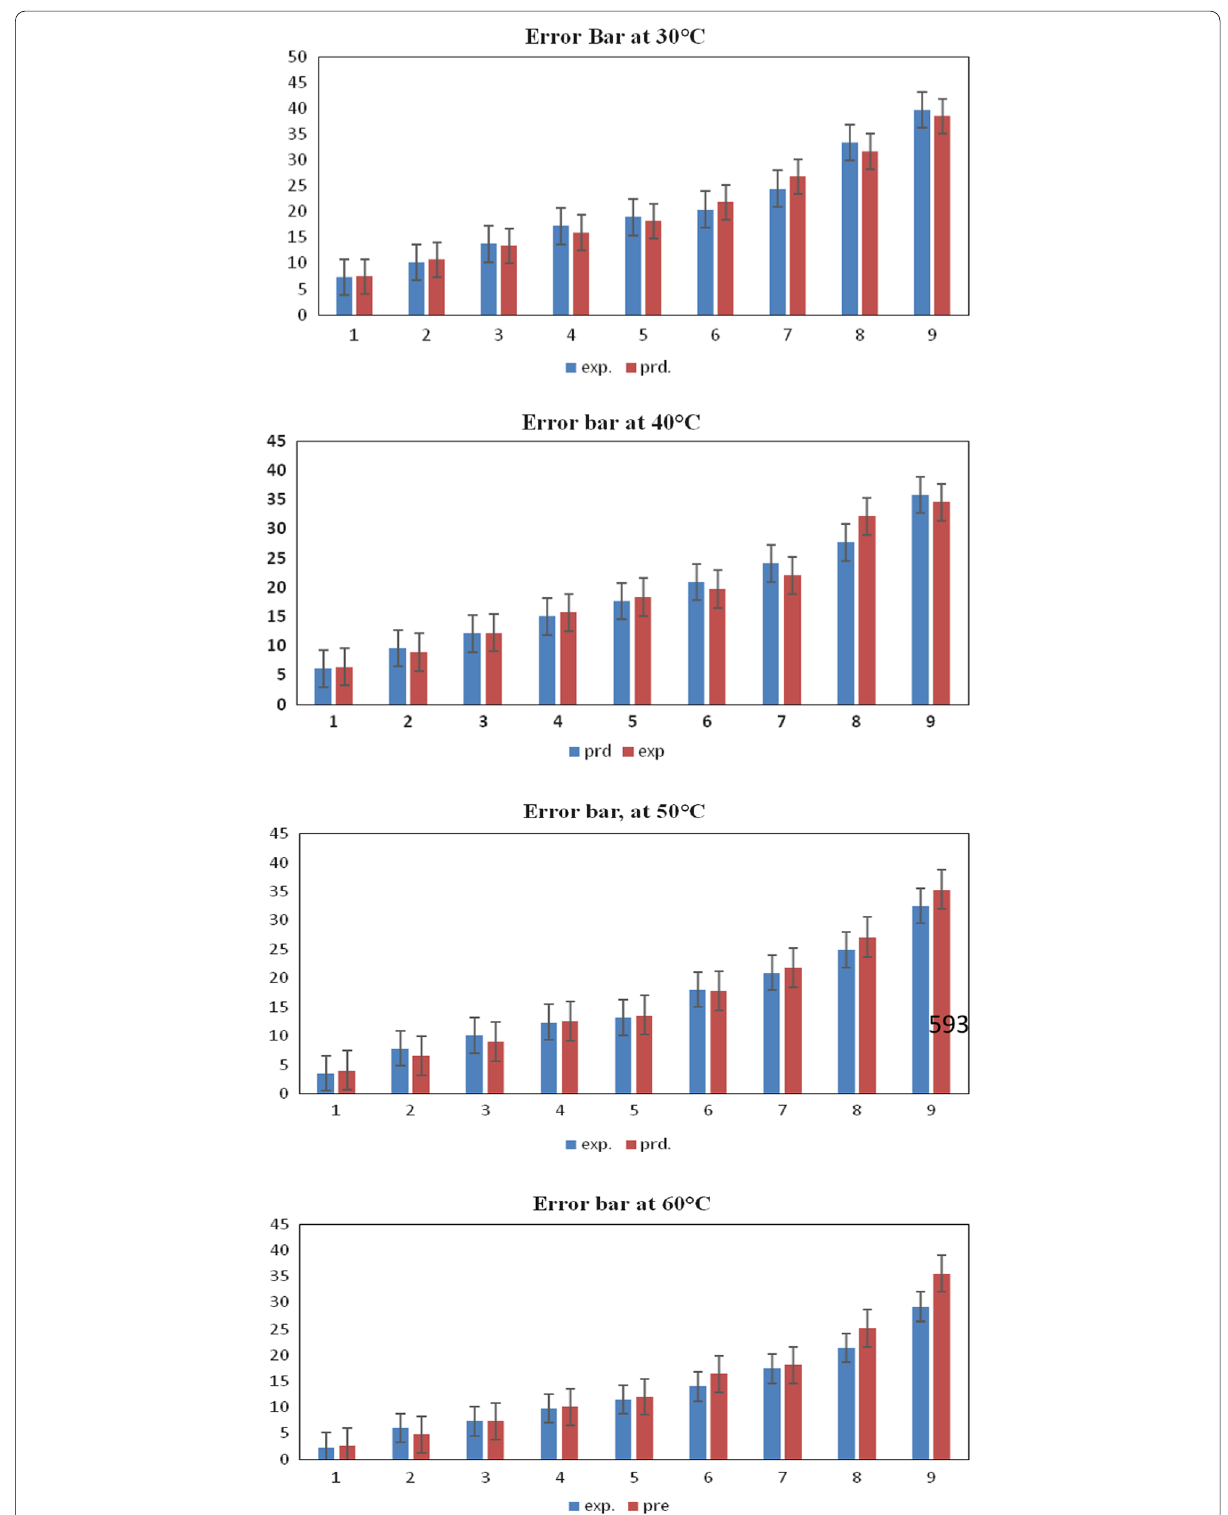
Fig. 4 Comparison of experimental and predicted sorption isotherm of karaya gum using GAB model through error